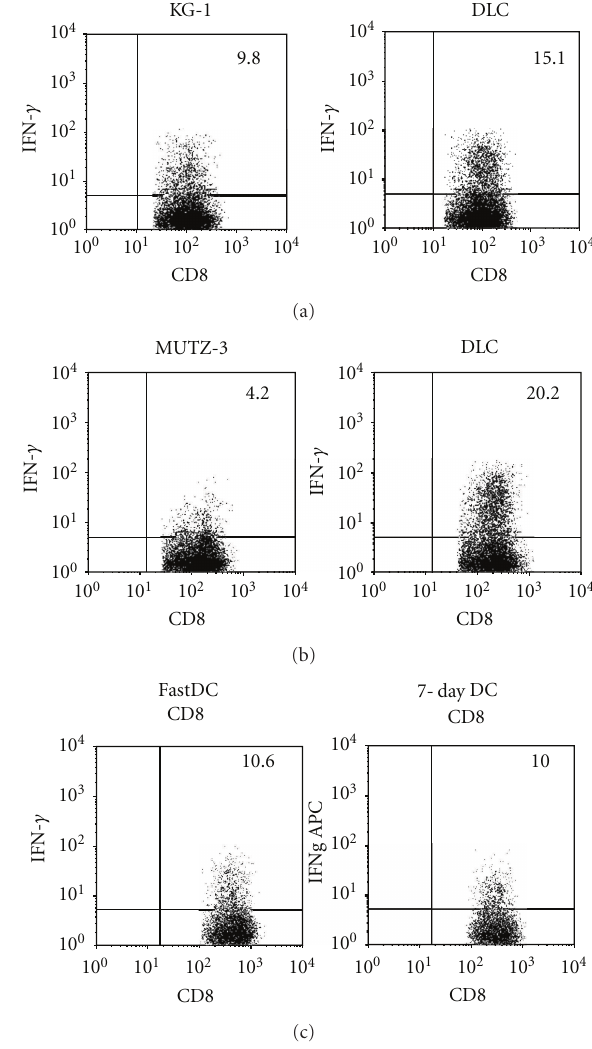
Figure 7: IFN- γ production from CD8 + T cells. Irradiated KG-1 (a), MUTZ-3 (b) and the derived DLC as well as FastDC and 7-day culture DC derived from PBMC (c) were cocultured at the ration of 1:10 for 4 days with 5 × 10 5 responder PBMC loaded with CFSE. Before cells were harvested for IFN- γ assay, 10 ng/mL PMA and 200 ng/mL ionomycin were added into the culture for the last 16hrs of incubation. Cells analysed were gated on CFSE positive CD8 + T cells. One representative result is